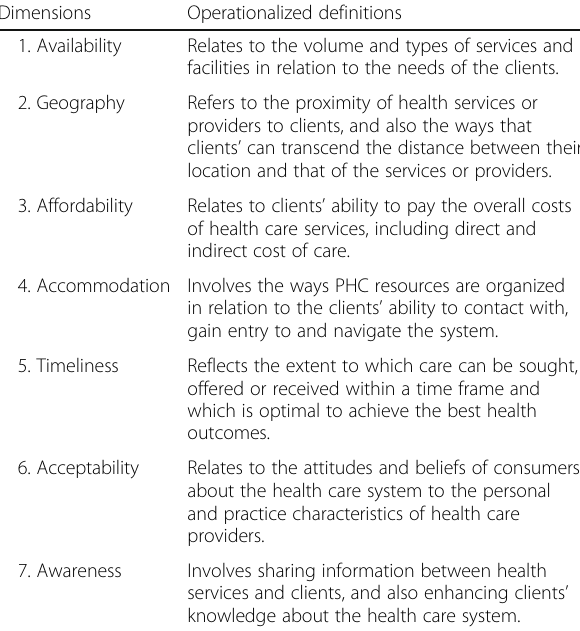
Table 2 Rural primary health care access framework